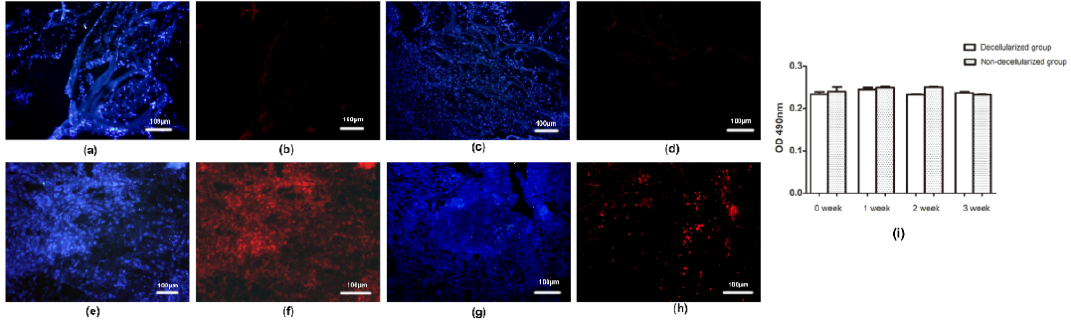
Figure 8. Immunohistochemical staining ( × 200). After the porcine decellularized scaffold was implanted in rabbits for 2 weeks ( a – d ) and 4 weeks ( e – h ), the scaffold and surrounding tissues were fluorescently labeled with CD4+ \ CD8+ lymphocyte subsets. The blue bright spot showed the nucleus, the red spot in ( b , f ) showed the presence of CD4+ lymphocytes, and the red spot in ( d , h ) showed the presence of CD8+ lymphocytes. ( i ) Quantitative results of the CD4+ \ CD8+ lymphocyte subsets in decellularized and non-decellularized cartilage scaffolds.